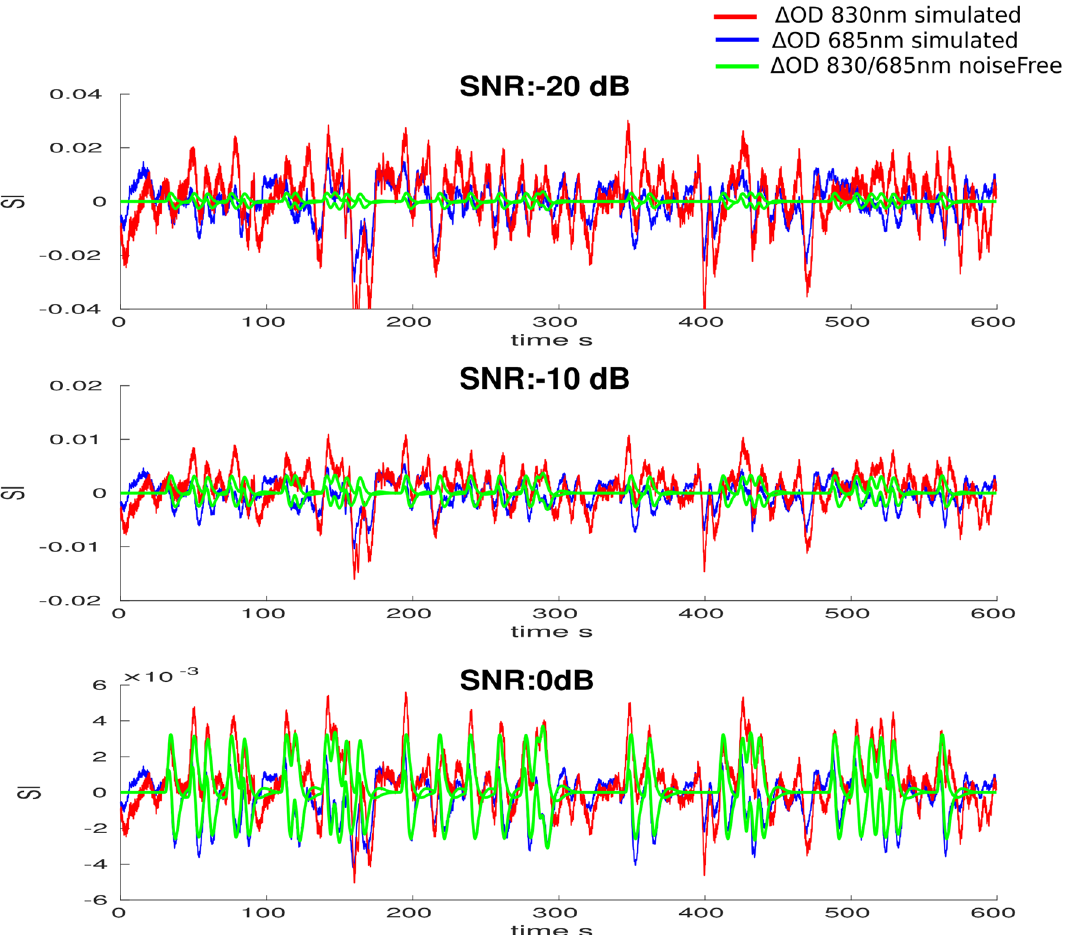
Figure 3. Realistic simulations of fNIRS data: (cid:31) OD sim at 830 nm (red) and 685 nm (blue) simulated at different SNR levels on the scalp surface of one anatomical model and for the most sensitive pair to the target ROI. Noise free simulated (cid:31) OD are represented in green for both